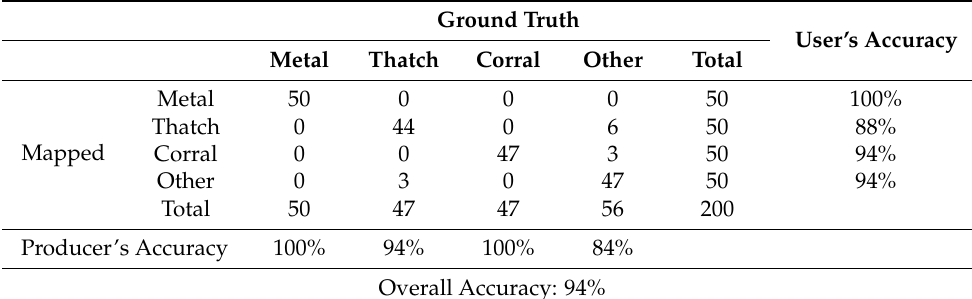
Table 5. Confusion matrix associated with the classification of the 2012